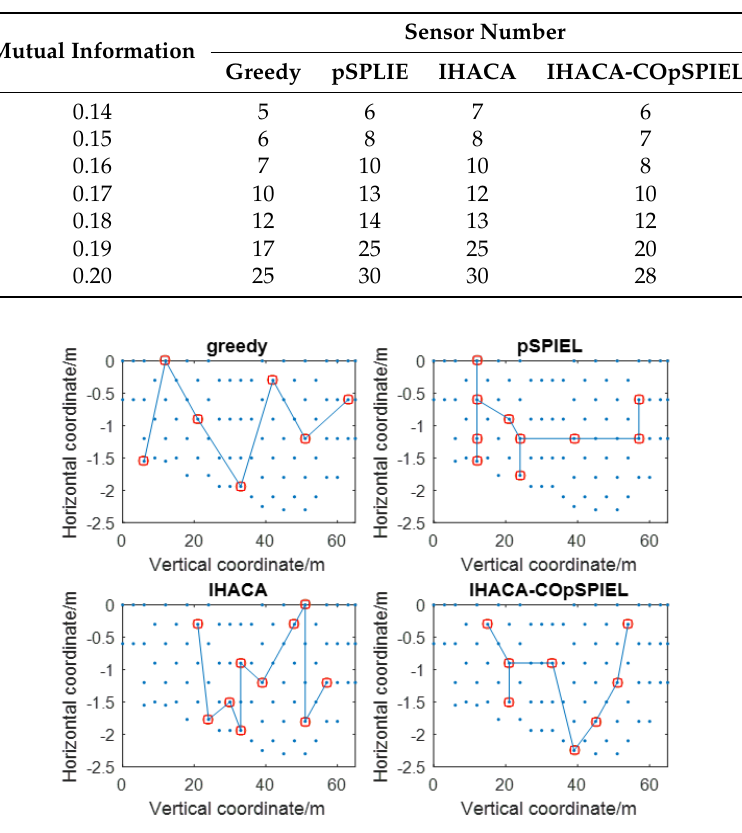
Table 3. Comparison of sensor number for the four algorithms.